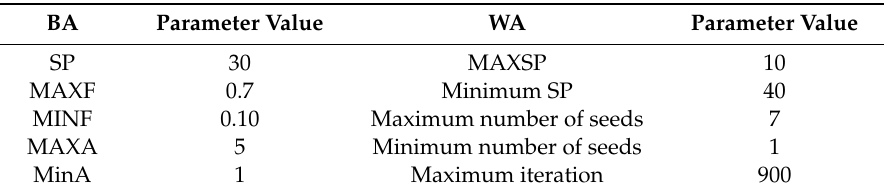
Table 3. The optimum values of BA and WA parameters.